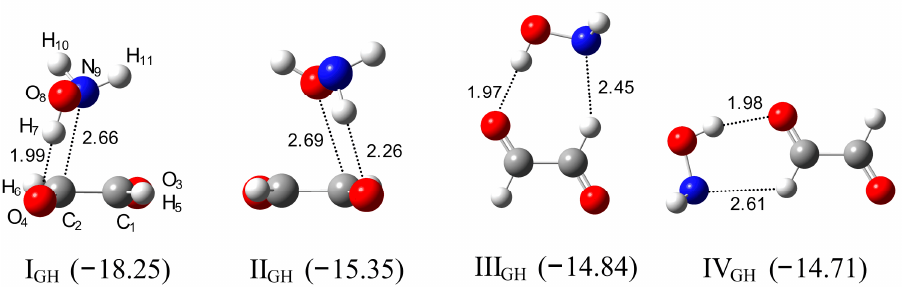
Figure 3. The optimized structures of the CHOCHO–NH 2 OH complexes, I GH –IV GH . The ∆ E CP (ZPE) ‐ binding energies in kJ mol − 1 are given in parentheses. The intermolecular distances are given kJ mol − 1 are given in parentheses. The intermolecular distances are given in in Å.